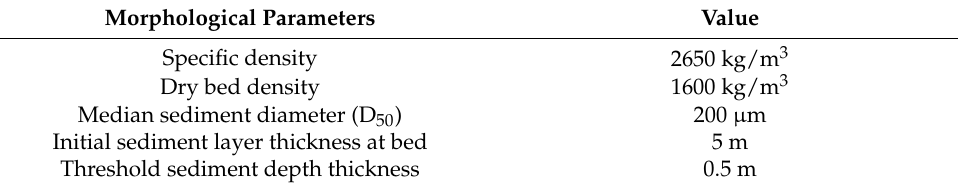
Table 4. Morphological